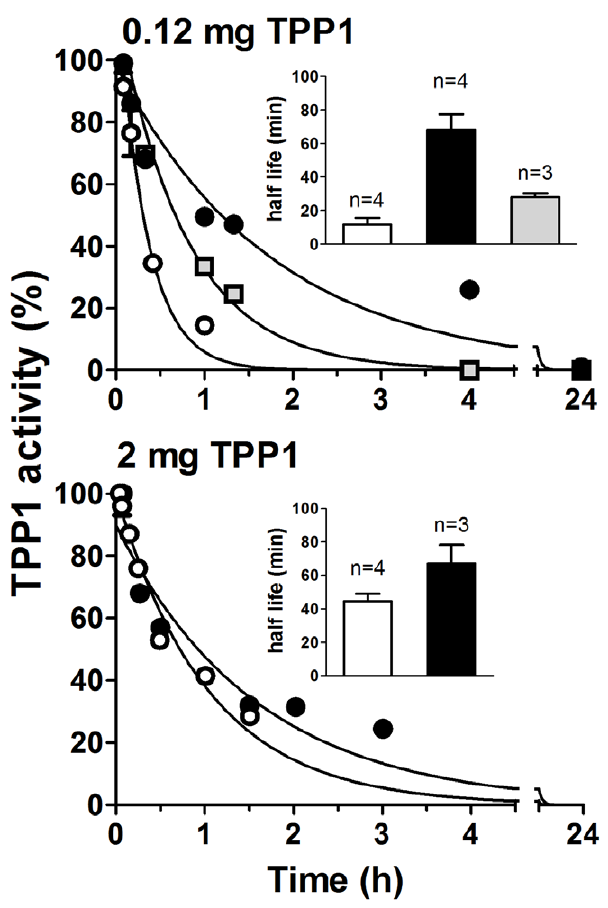
Figure 6. Plasma circulatory half-life of TPP1 preparations. Tpp1 ( 2 / 2 ) mice were administered 0.12 mg ( Top ) or 2 mg ( Bottom ) of unmodified or modified TPP1 via tail vein injection and plasma samples collected via cheek puncture at indicated times. Unmodified TPP1, open circles; OX-TPP1, filled circles, DG-TPP1, gray squares. Plasma TPP1 activity was assayed after preactivation, normalized to the percentage of the activity at the initial time point and fit to a single phase exponential decay model constraining the plateau value to 0%. Curves show a single representative animal for each condition and insets represent mean and SEM for the indicated number of animals.